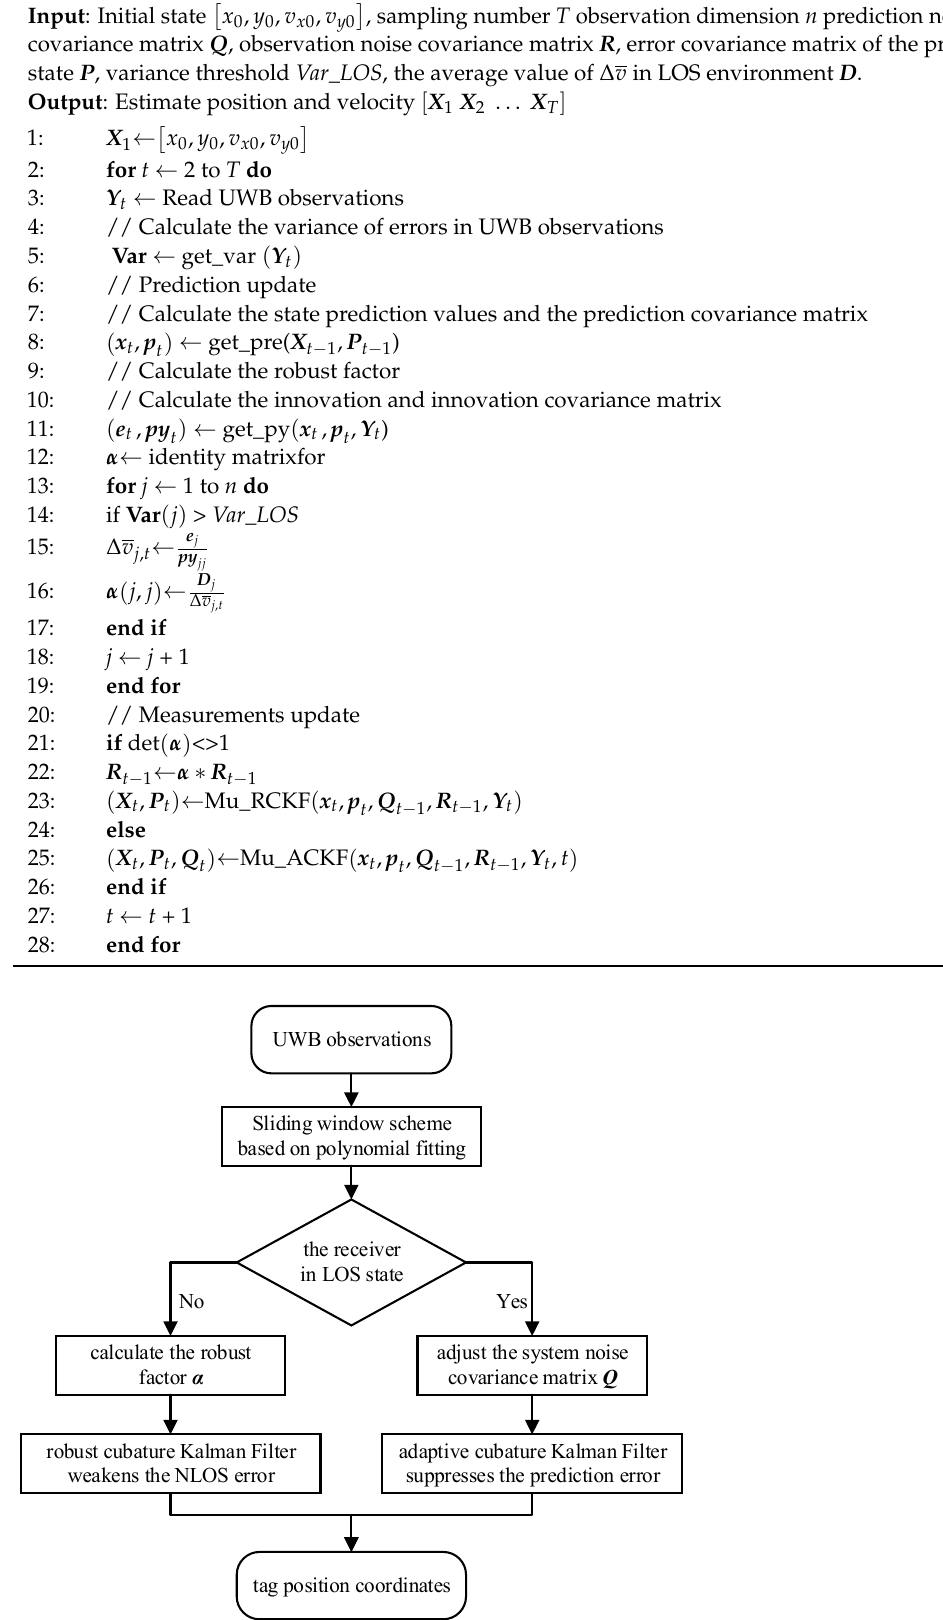
Figure 5. The flow chart of the IRACKF.